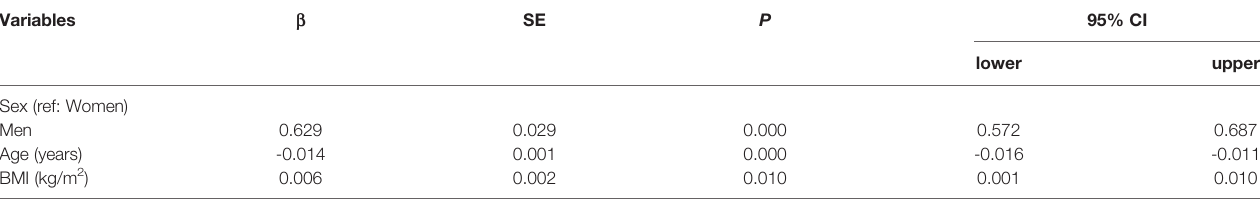
TABLE 2 | Independent in fl uence factors analysis for Chinese 50kHz-phase angle when age and BMI as continues variables. Variables